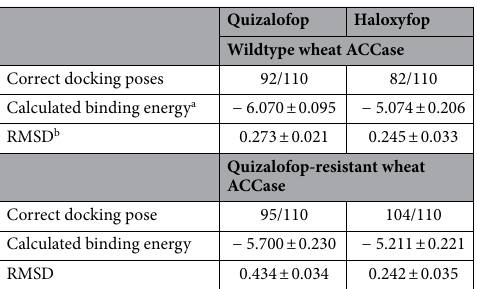
valine. The asterisk in Fig. 5B highlights the strong steric hindrance between the volume occupied by the valine side chain and the 6-chloro-quinoxalin-2-yl group of quizalofop. The same A2004V amino acid substitution does not prevent binding of haloxyfop (Fig. 5D).